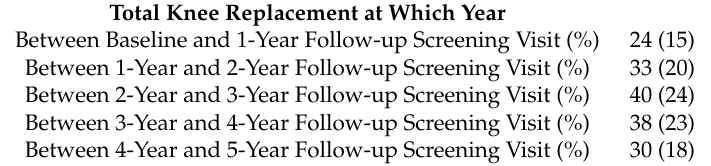
Table 1. Cont . Total Knee Replacement at Which Year Between Baseline and 1-Year Follow-up Screening Visit (%) 24 (15) Between 1-Year and 2-Year Follow-up Screening Visit (%) 33 (20) Between 2-Year and 3-Year Follow-up Screening Visit (%) 40 (24) Between 3-Year and 4-Year Follow-up Screening Visit (%) 38 (23) Between 4-Year and 5-Year Follow-up Screening Visit (%) 30 (18)